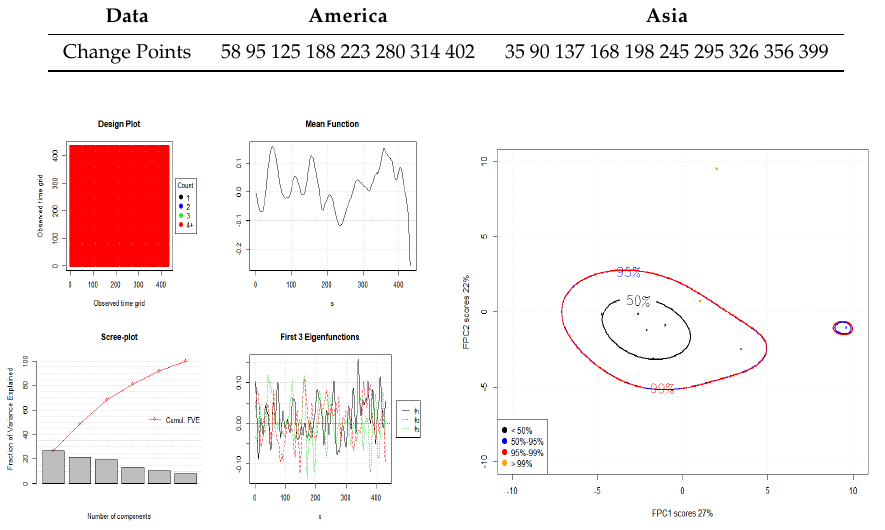
Table 20. Change point detection with the James, Zhang, and Matteson (2019) nonparametric multiple change point analysis with real exchange currency data of America (1/3/2013 to 10/3/2014) and Asia (1/4/2013 to 10/6/2014).